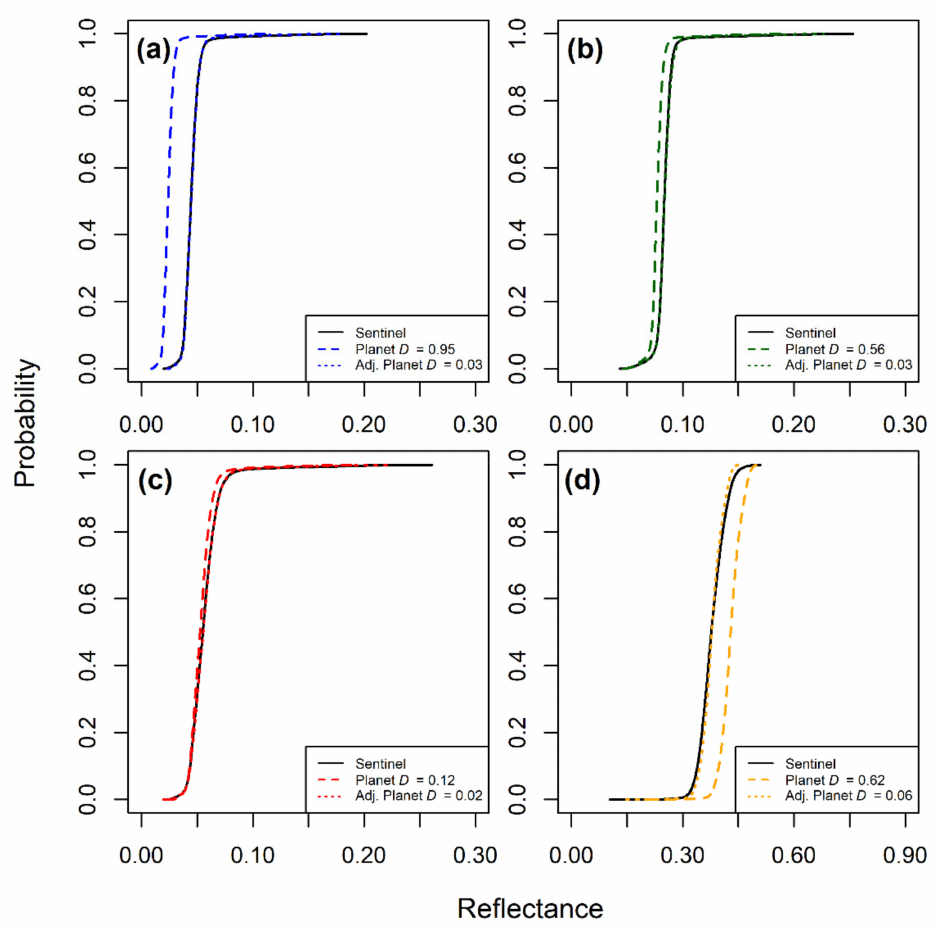
Figure 4. Empirical cumulative density functions of untransformed PS (Planet) and adjusted PS (Adj. Planet) through a Sentinel-2 based linear transformation for ( a ) blue, ( b ) green, ( c ) red, and ( d ) nir bands. Values are compared using the Kolmogorov–Smirnov test’s D statistic, which is nonnegative with values closer to 0 signaling similar distributions and larger numbers signaling dissimilar distributions. The image used was captured near Manhattan, KS,